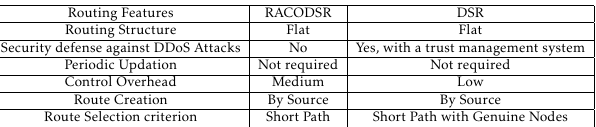
Table 1. Comparision of RACODSR and DSR Routing